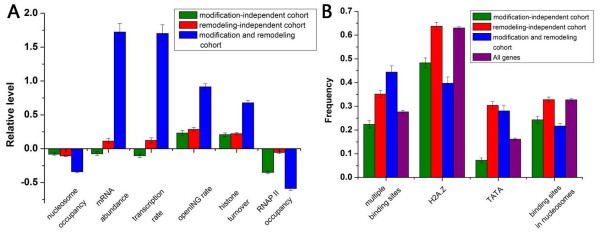
Gene features that distinguish the three cohorts. (A) Average values that correspond to nucleosome occupancy [34], transcription rate [26], gene expression level [26], openING rate, the turnover rate of H3 histone [27] and PNAP II occupancy [44] are shown for modification-independent cohort (green), remodeling-independent cohort (red) and modification and remodeling cohort (blue). Values in each property were normalized (nucleosome occupancy and turnover rates were normalized among all promoters, RNAP II occupancy were normalized among all 200 bp upstream regions), such that their means are zero and standard deviations are one. (B) Ratio of transcription factor binding sites [37] localized in nucleosome [34], as well as ratio of promoters with multiple binding sites [37], TATA box [41], and H2A.Z [42] is shown for modification-independent cohort (green), remodeling-independent cohort (red), modification and remodeling cohort (blue) and all genes (purple). Error bars were calculated by bootstrapping.